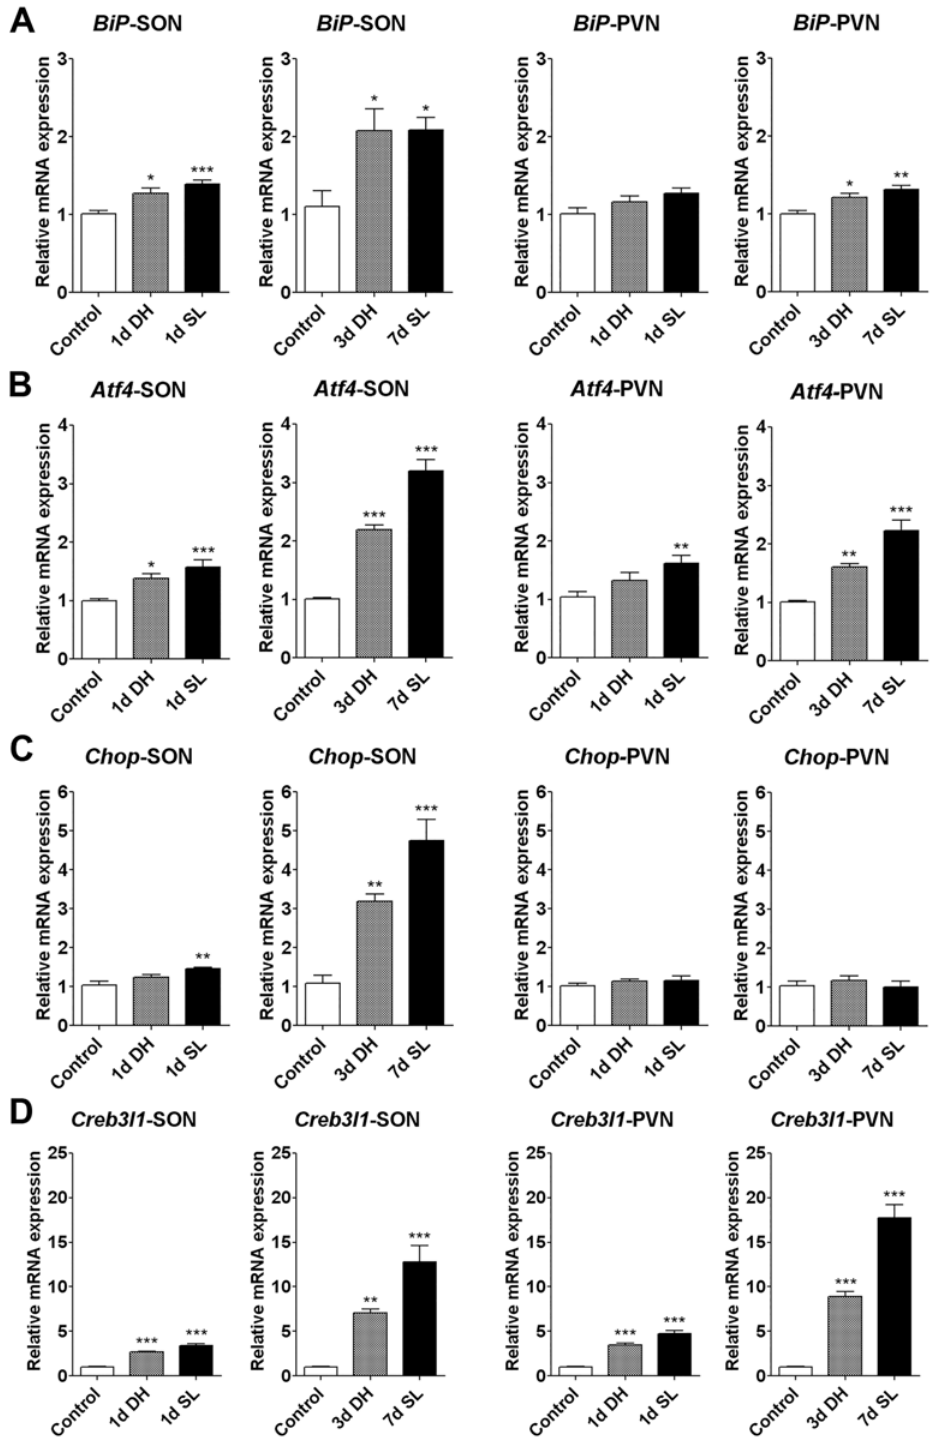
Fig 1. UPR-target genes increase in expression in response to hyperosmotic stress. Relative mRNA expression of (A) BiP , (B) Atf4 , (C) Chop , and (D) Creb3l1 in the SON and PVN of 1 day and 3 days DH and 1 day and 7 days SL rats was examined by qPCR (n = 5 – 8). Error bar, +SEM, * p < 0.05, ** p < 0.01, *** p < 0.001. d, day; DH, dehydration; SL, salt loading; SON, supraoptic nucleus; PVN, paraventricular